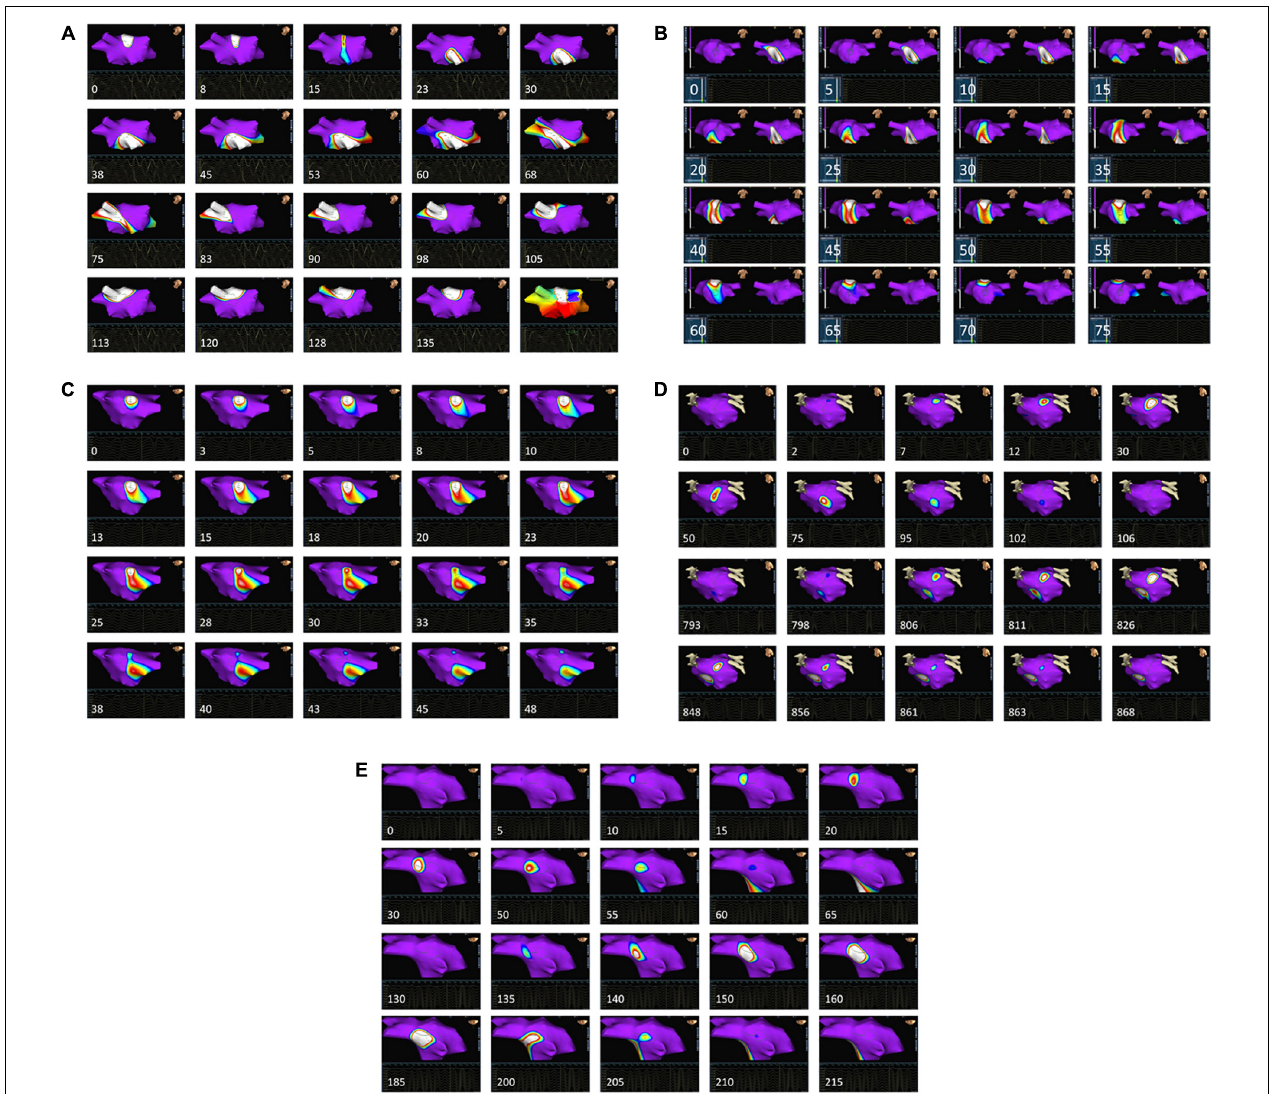
FIGURE 2 | Patterns of pre-ablation isopotential map behavior in and around HDF regions. For each case, the temporal sequence is from left to right and top to bottom. The timing of each frame relative to the first is given in ms. Each image is centered around an area that was subsequently ablated based upon the presence of HDF spatial centers. Purple areas on the map represent atrial myocardium where local activation is absent, as defined by a local vEGM (virtual electrogram) amplitude above –0.28 mV. Voltages of –0.53 mV or less display as white, with the remainder of the color scale defining intermediate values. The appearance and trajectory of color around the maps were used to define the following wavefront activation patterns: (A) Rotor-like behavior, seen on the LA roof. The final panel shows an isochronal map of the area during this period, confirming rotational activity. AFCL was not significant altered by ablation in this region. (see also Supplementary Video 1 ). (B) Activation passes through the posterior wall of the LA three times consecutively (see Supplementary Video 2 ) within a single TQ period, but ablation here did not alter AFCL. (C) A wavefront is seen to split into two independent wavefronts on the LA roof, with the division occurring within the ablated area. AFCL was not significantly affected by ablation here (see also Supplementary Video 3 ). (D) Focal activation occurs near the left upper pulmonary vein, migrating out of the ablated area before extinguishing, as also demonstrated in Supplementary Video 4A . Later on, the same area is seen to activate again from an identical origin ( Supplementary Video 4B ), this time extinguishing within the lesion. Ablation here terminated AF to an atrial tachycardia. (E) A recurring focal extinction event, occurring on the LA roof. Focal activation arises outside the ablated region, then moves into and extinguishes within the ablated area (first 10 images). This behavior is repeated again shortly afterward (last 10 images) within the same TQ interval. See also Supplementary Video 5